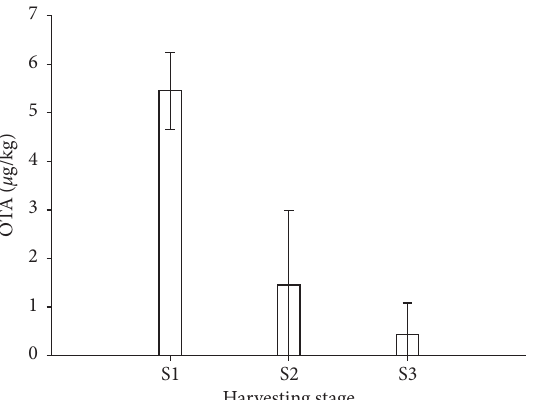
Figure 6: Mean OTA content of coffee samples collected at different processing steps. S1 � I (dry cherries); S2 � II (dry husk); S3 � III (green coffee beans).